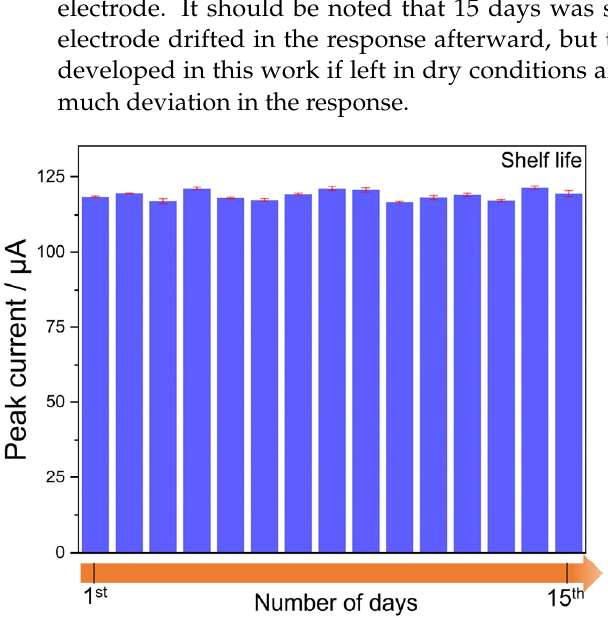
Figure 9. Bar visualization of minimal deviation in EdAu/SPCE towards nitrite over 15